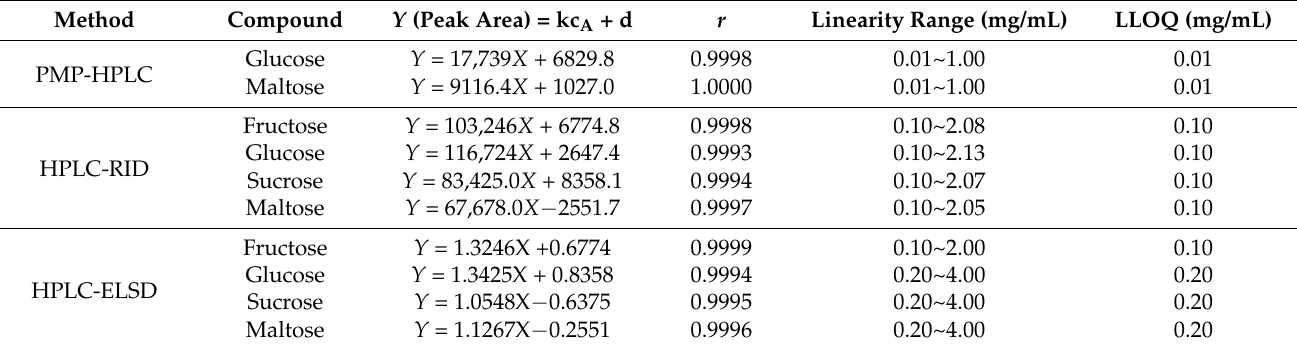
Table 2. HPLC assay accuracy for compounds. Inter-day recovery values (n = 6) expressed in percentage amount added (mean ± RSD).